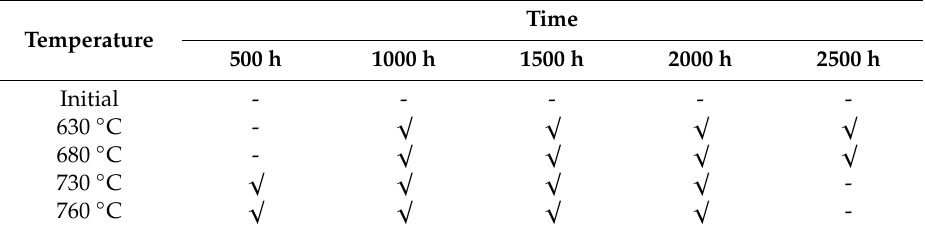
Table 1. Experimental parameters of thermal exposure